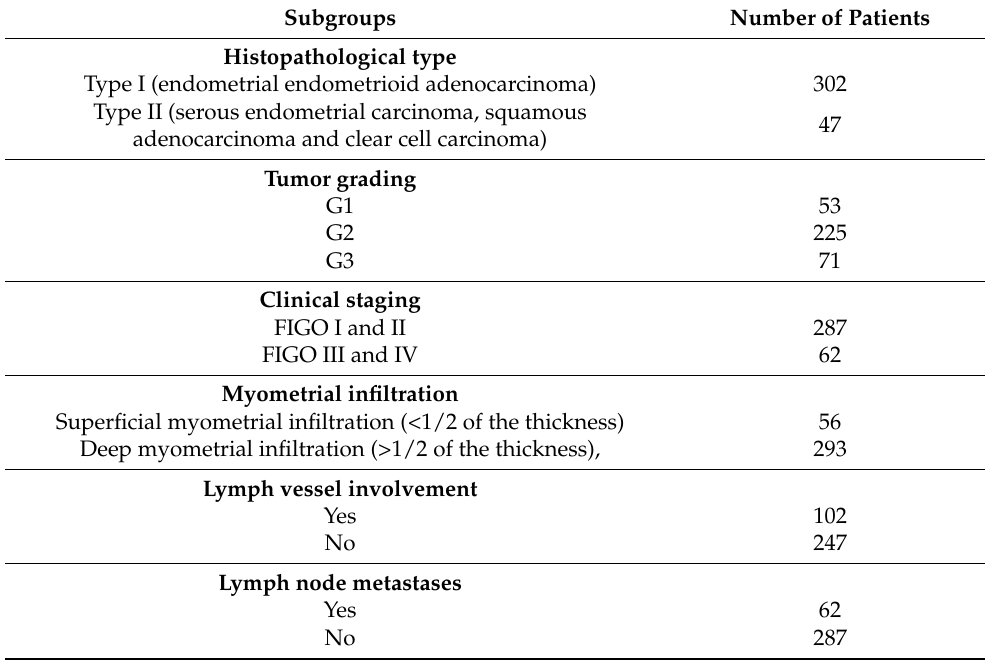
Table 1. Clinicopathological characteristics of the patients with endometrial cancer divided into subgroups. Subgroups Number of Patients Histopathological